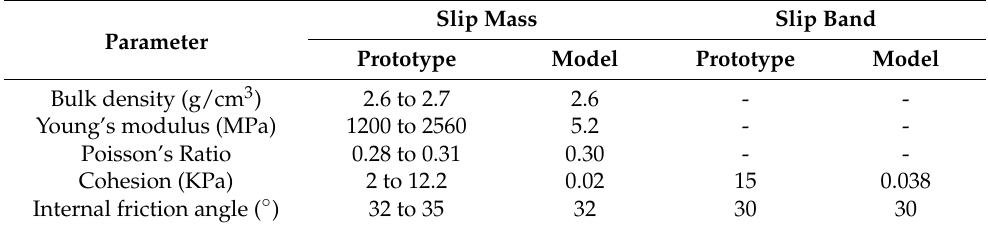
Table 1. Comparison between the prototype material parameters and the model material parameters.